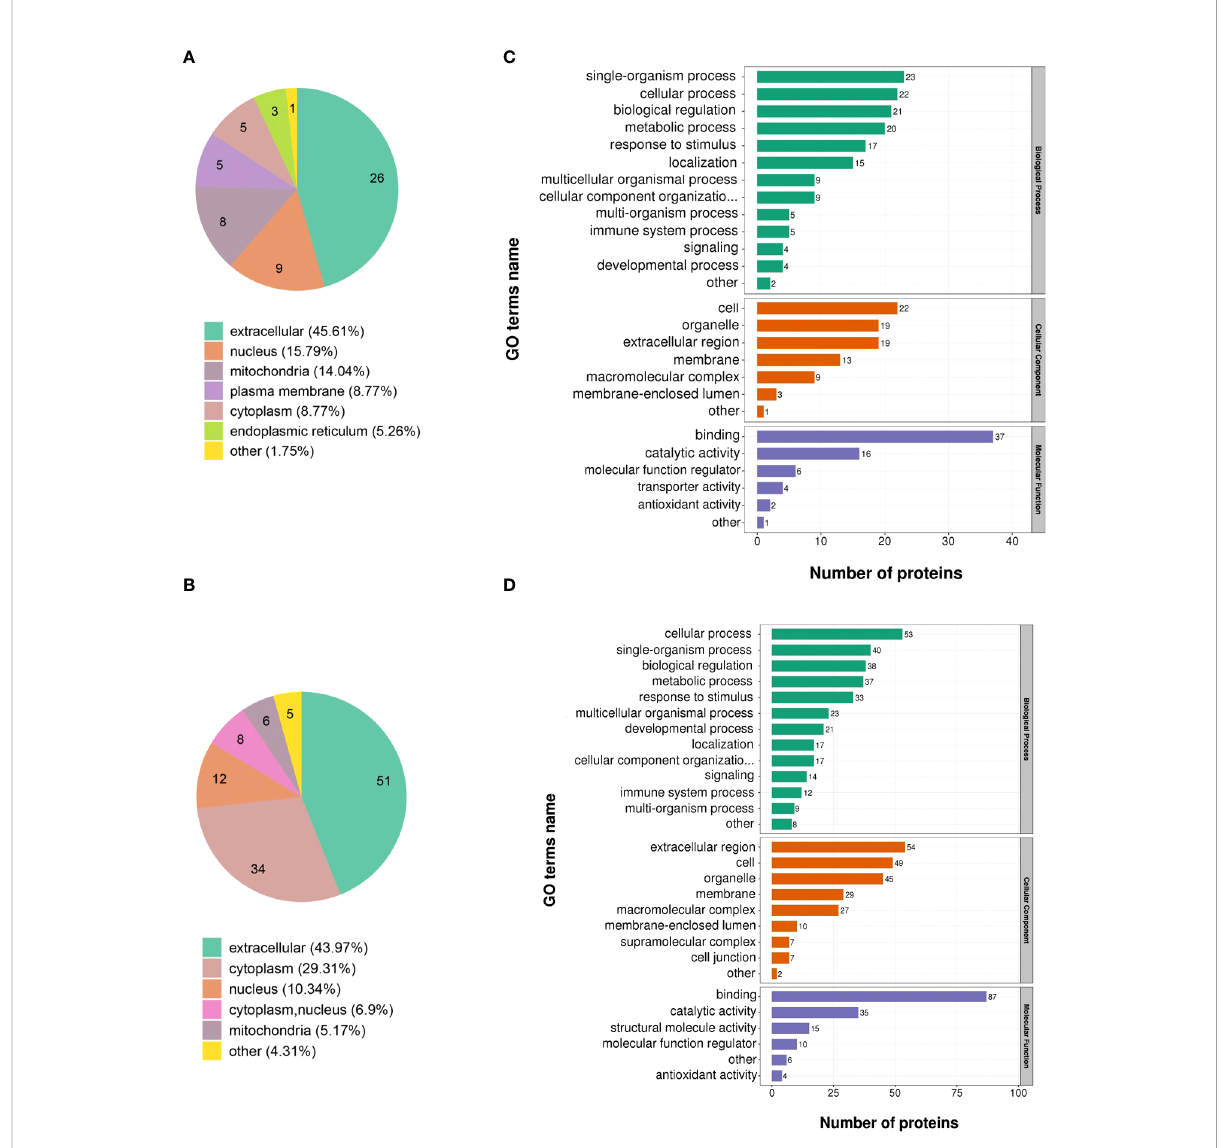
FIGURE 2 Functional analysis of the DEPs identi fi ed through quantitative proteomics in ASFV-infected versus uninfected samples. Subcellular structural analysis of (A) upregulated DEPs and (B) downregulated DEPs. GO enrichment analysis of (C) upregulated DEPs and (D) downregulated